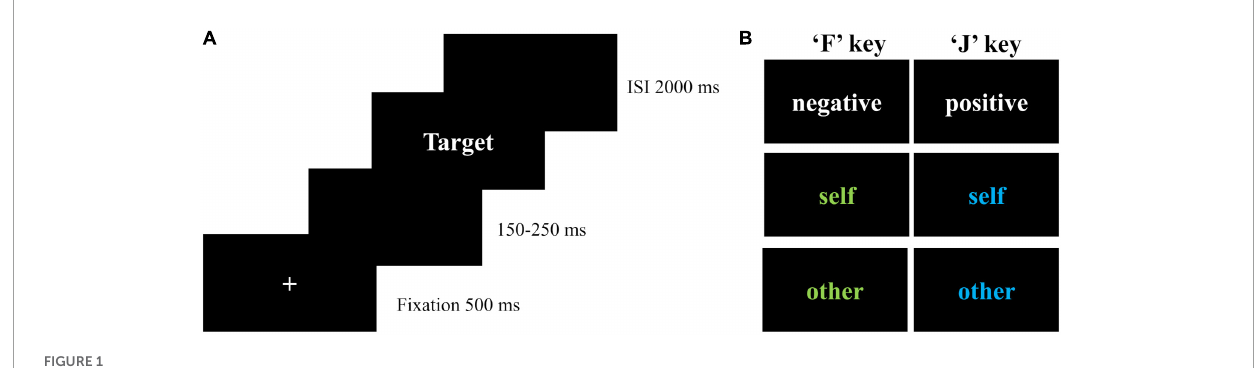
FIGURE1 Extrinsic affective Simon task. (A) Flowchart of each trial; (B) conditions in EAST; ISI, inter-stimulus interval; self-words included I, myself, me, and self ( in Chinese). Other-words included dad, mom, partner, and lover ( in Chinese). Positive words included nice, warm, lovely, kind, excellent, and capable ( ). Negative words included terrible, incompetent, useless, evil, lame, and disgusting (